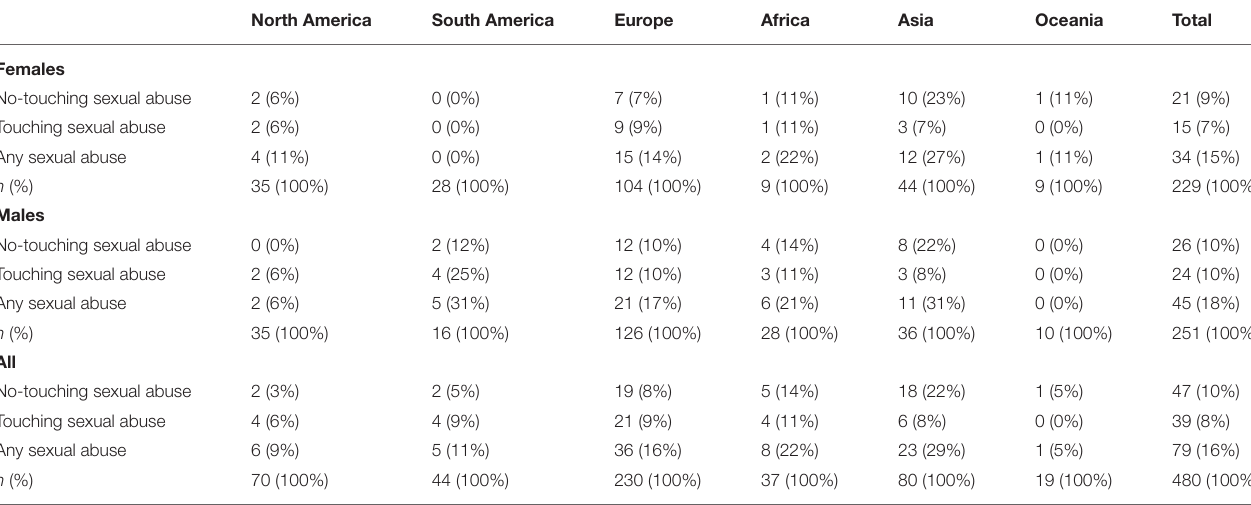
TABLE 5 | Lifetime sexual abuse experiences outside Athletics displayed by global geographical region.